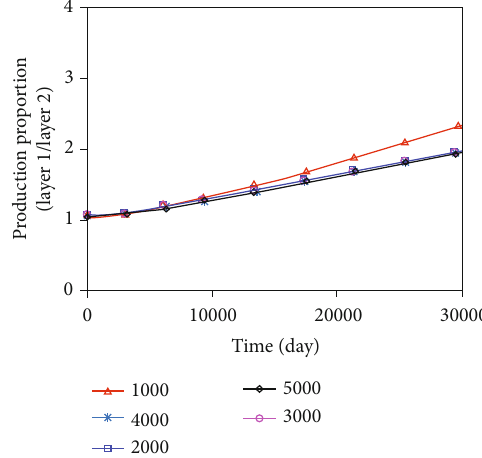
Figure 5: The e ff ect of the wellhead production rate on